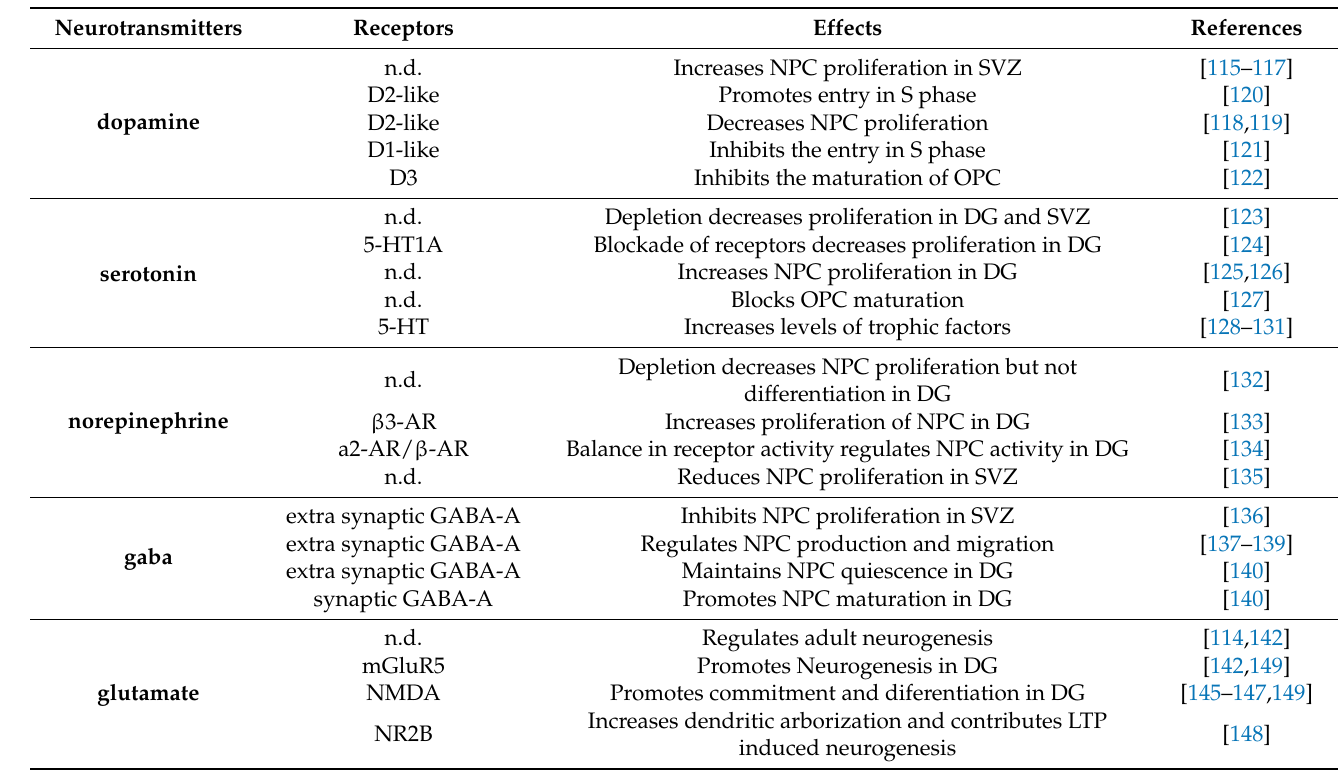
Table 2. Neurotransmitters: beyond the neuronal